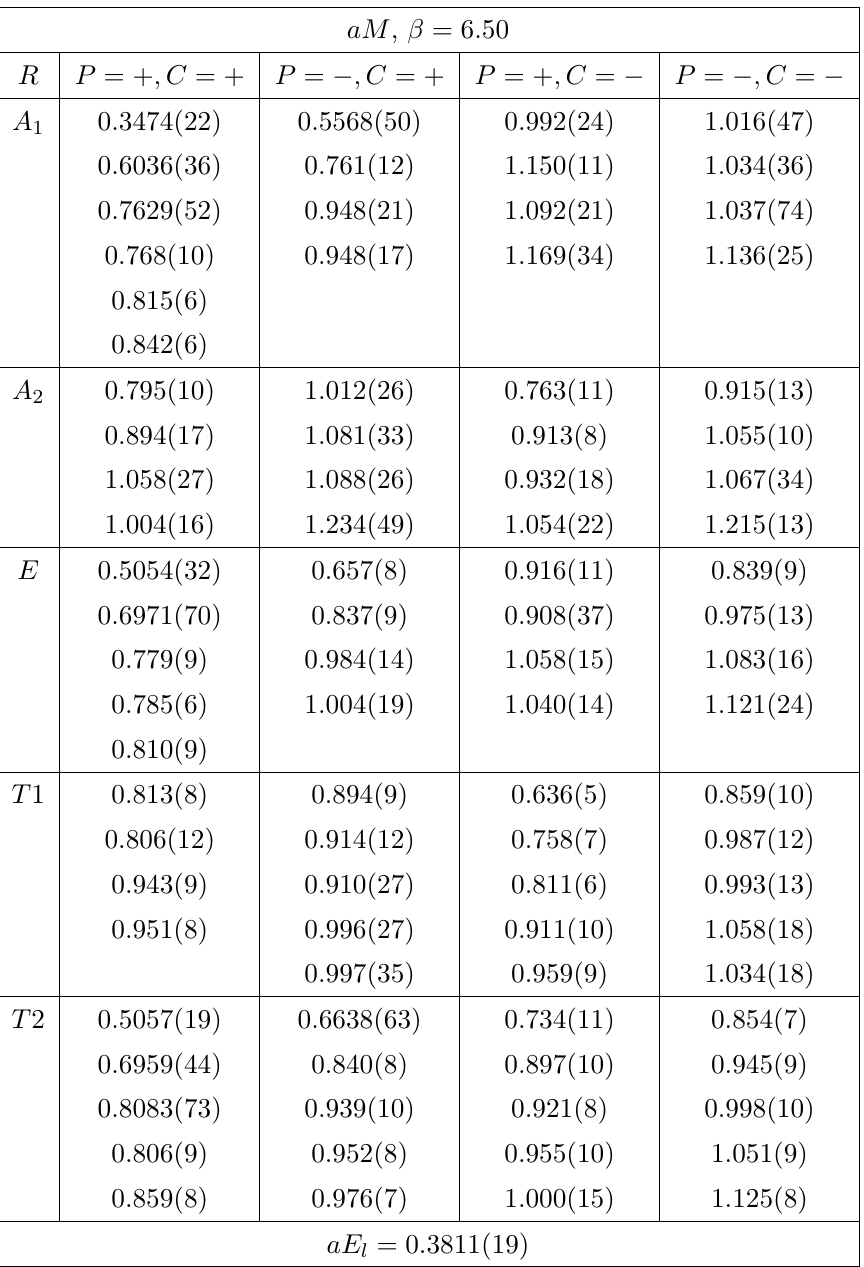
Table 13 . Glueball masses at β = 6 . 50 on a 38 4 lattice for all octahedral representations, R , and for both values of parity, P , and charge conjugation, C . Also the energy E l of a winding flux